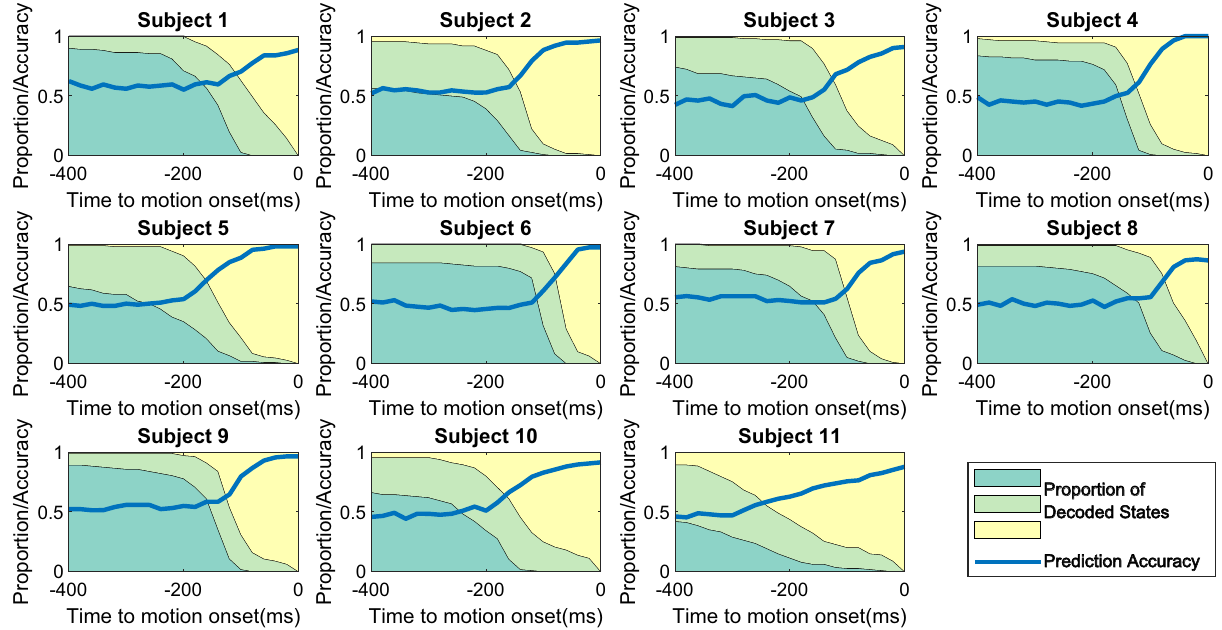
Figure 6. Converging hidden-states vs. prediction accuracy during motion initiation. The shaded regions of different colors represent the changing distribution of the 3 decoded hidden states among all the samples, hence always add up to 1 at each time point: the dark green region represents the first-order hidden state, the light green the second-order hidden state, and the yellow the third-order hidden state. The curve of the prediction accuracy rate is also